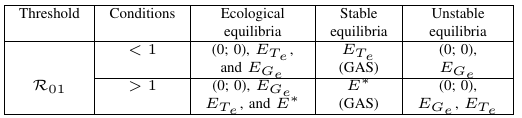
TABLE I: Stability/Instability results for Tilman’s